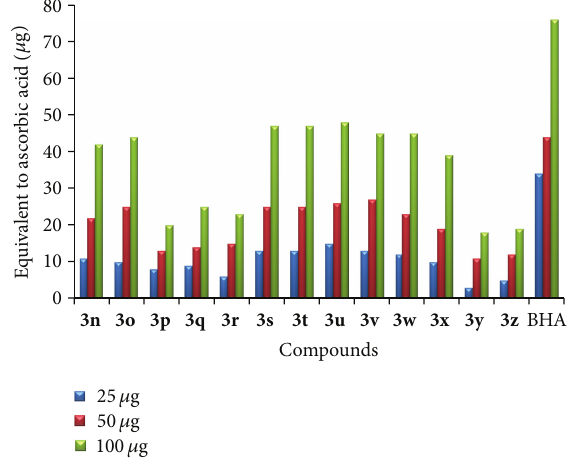
Figure 4: Total antioxidant capacity of 3n – z .